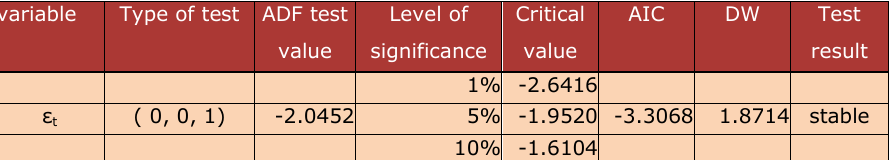
Table 3. The stationary test of residuals ε